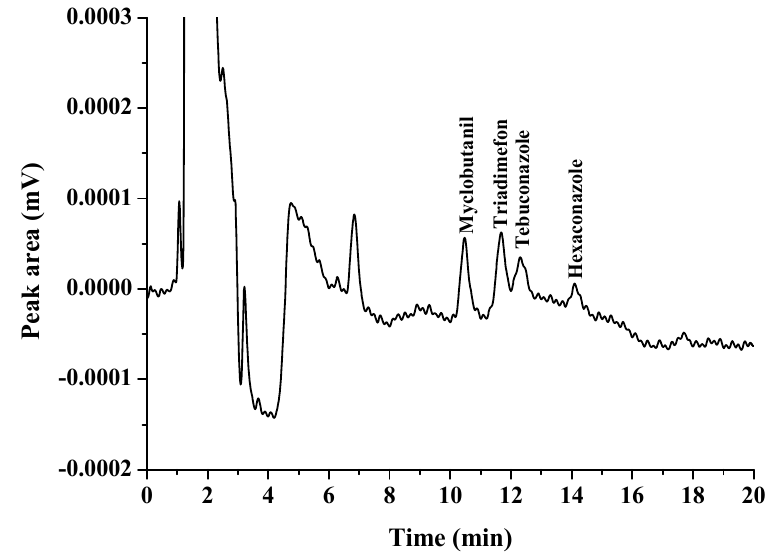
Figure 2. Extraction of triazole fungicides using 1-undecanol as a solvent.